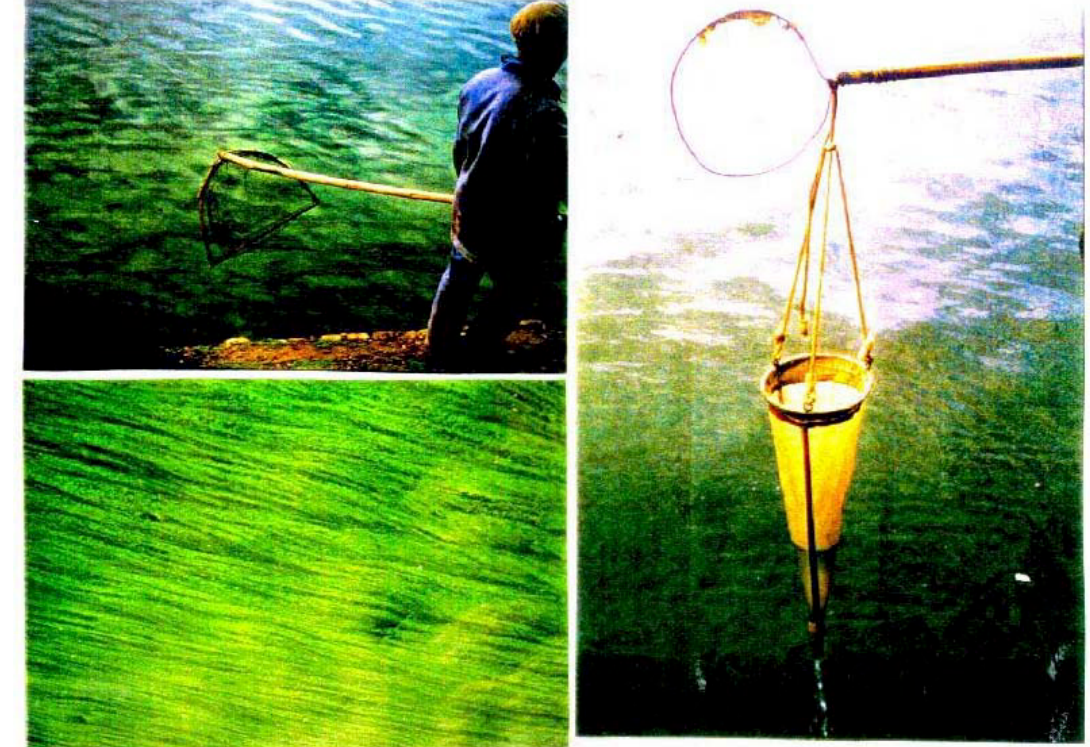
FIGURE 3. Cyanobacteria blooms in Lake Donghu on October 9, 1981 (photo by K.